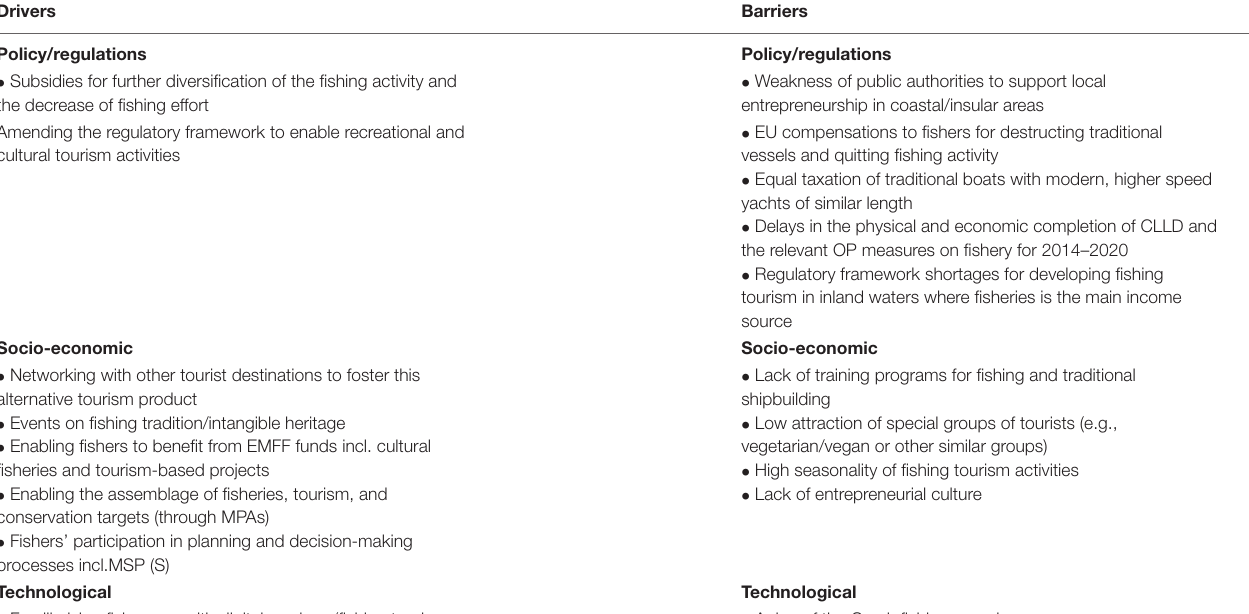
TABLE 2 | The MU fisheries/tourism/environmental protection in Greece,